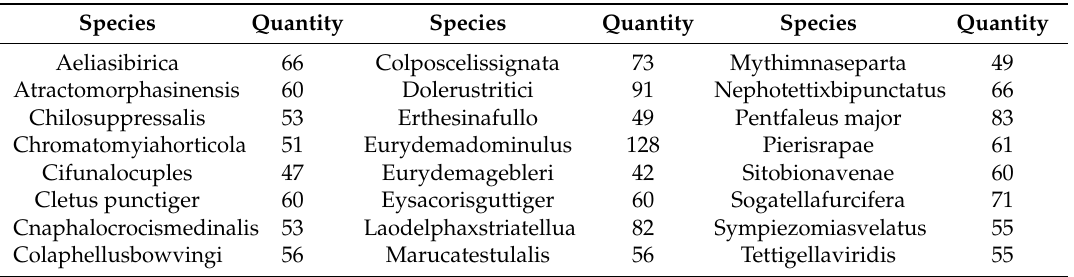
Table 1. Information of 24 insect species collected from Xie’s data set, crop fields and the Internet.